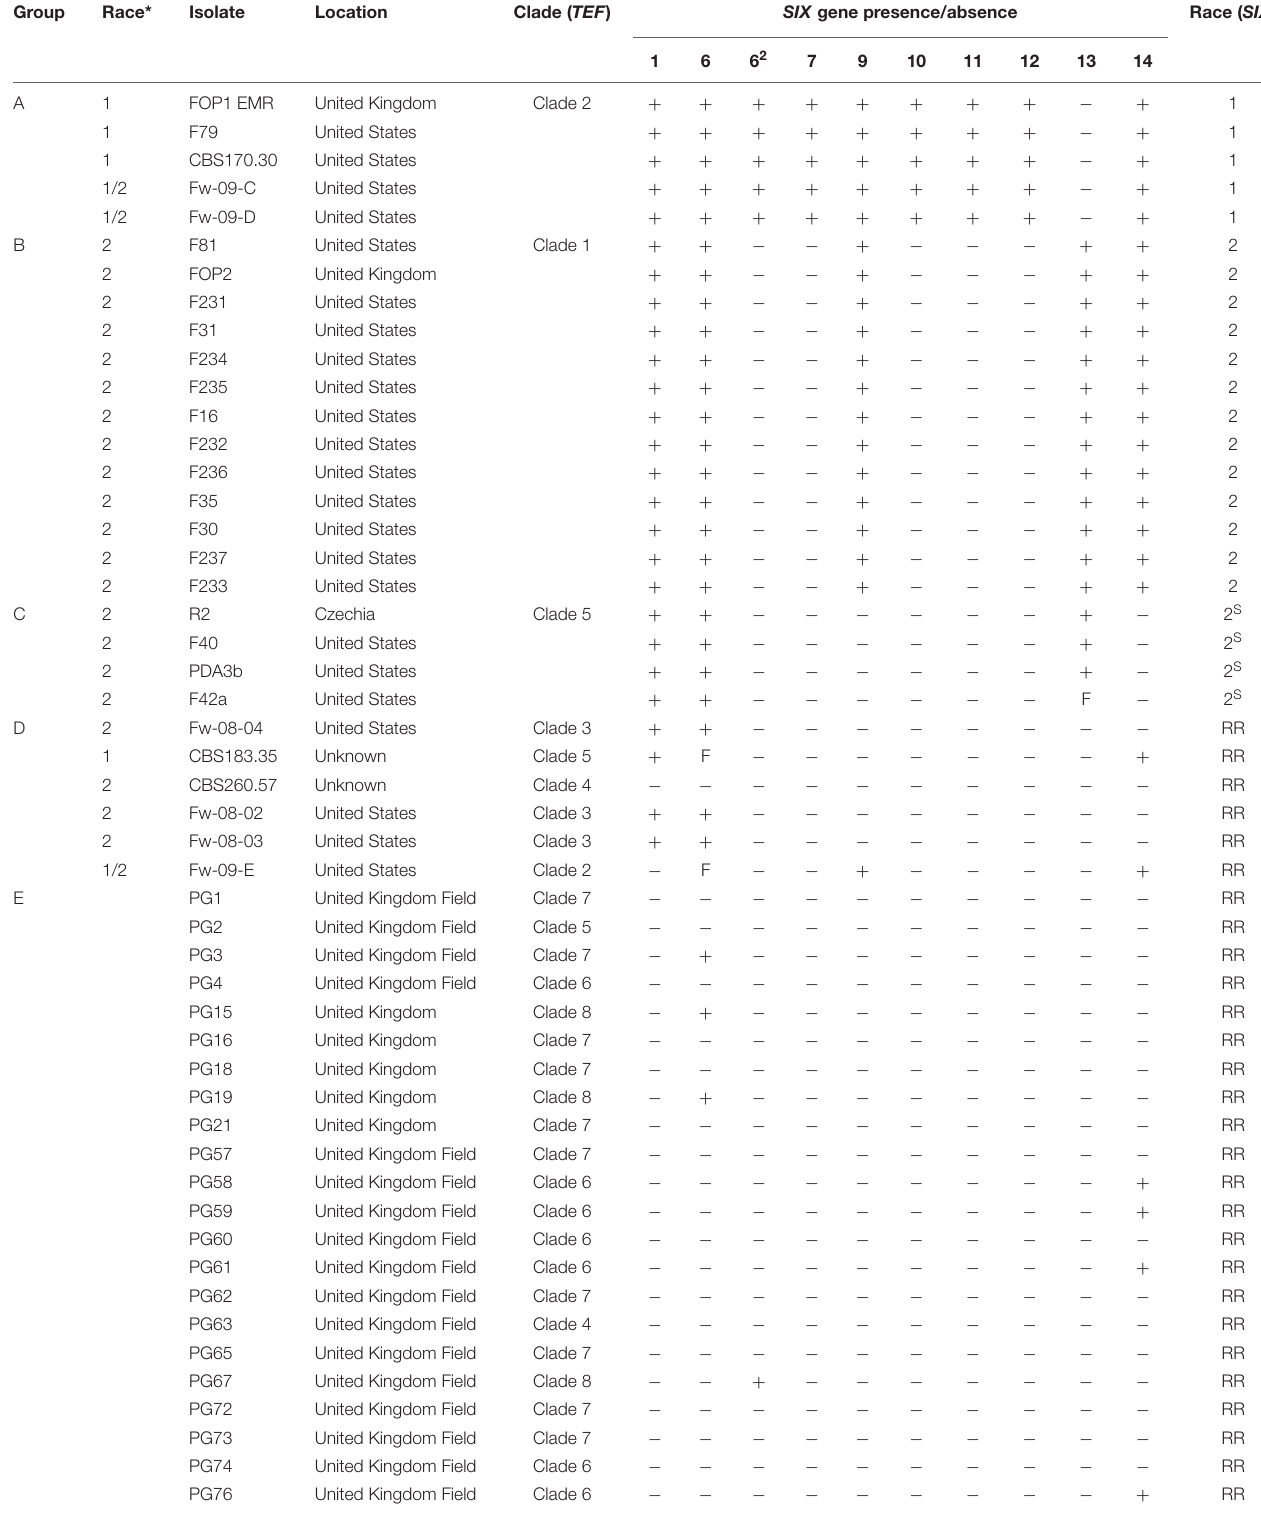
TABLE 1 | Presence and absence of Secreted In Xylem ( SIX ) genes found in Fusarium oxysporum isolates from diseased United Kingdom peas and in F. oxysporum f. sp. pisi (FOP) isolates from other researchers (with previous putative race designation) as determined by PCR. Group Race*